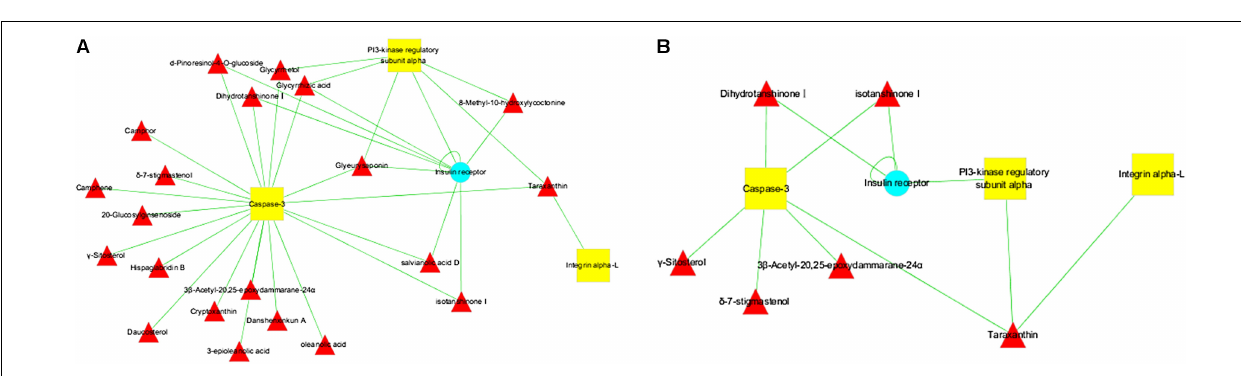
FIGURE 3 | Potential active ingredients-targets interaction network of SCG. (A) The network of potential active components with related targets. (B) The segregated network of active components with related targets. TABLE 2 | Information of active ingredients of SCG with the related targets and PK parameters. Compound Targets Herbs PK parameters